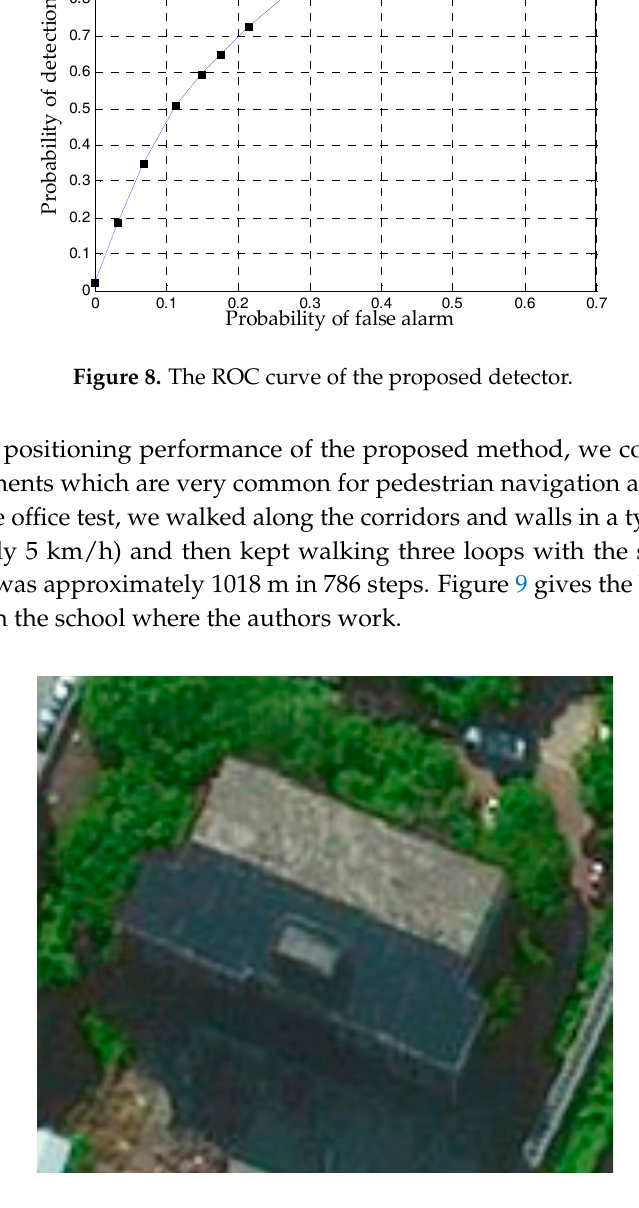
Figure 9. The bird’s eye view of the office test